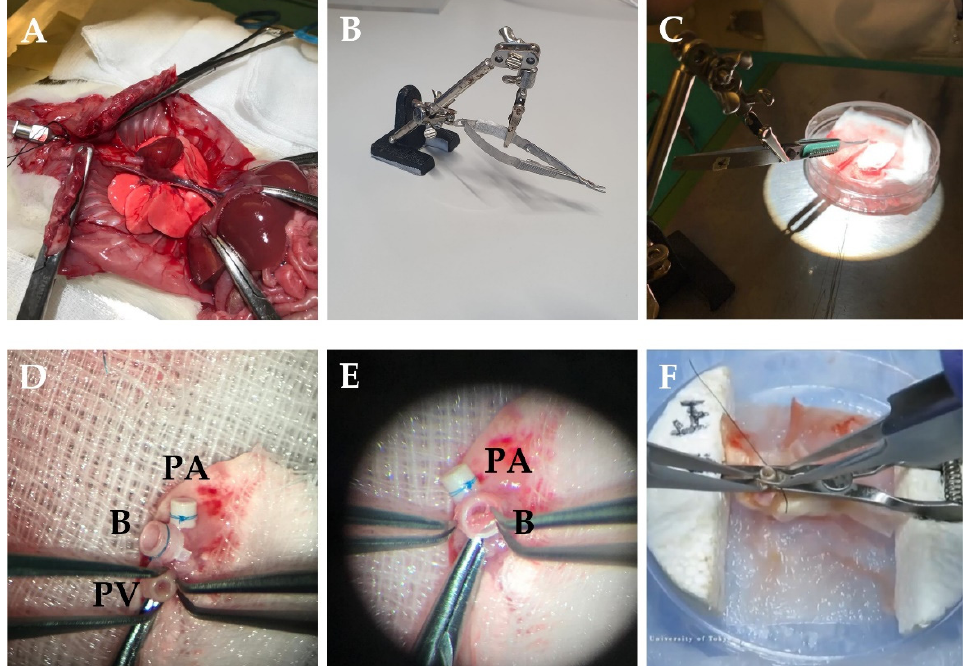
Figure 1. Donor procedure in rats LTx. ( A ) The chest wall is flipped outward with forceps and fixed on both sides. ( B ) Stabilizer with needle holder. ( C ) Benchwork for preparing donor lung. ( D ) The vessel is passed through the cuff, and tissue is folded over the cuff body and secured with a 7-0 nylon suture. ( E ) The bronchus is cuffed the same way as the vessels. ( F ) The bulldog clamp is set into foam blocks as a stabilizer for cuffing vessels and bronchus [25]. PV—pulmonary vein; B—bronchus; PA—pulmonary artery.